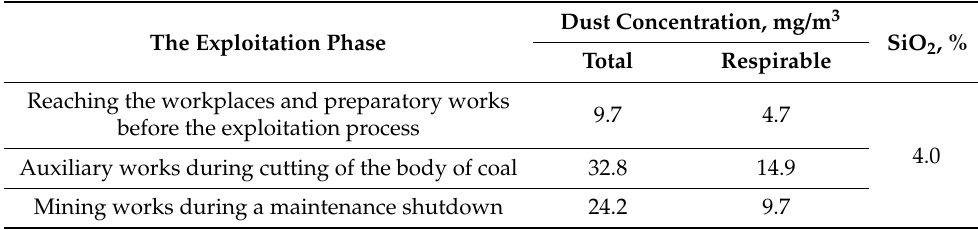
Table 9. The measurement results for the dust levels for selected activities, in the working position the assistant cutter-loader man.